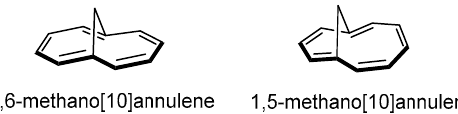
Figure 1. Vogel’s bridged annulenes.